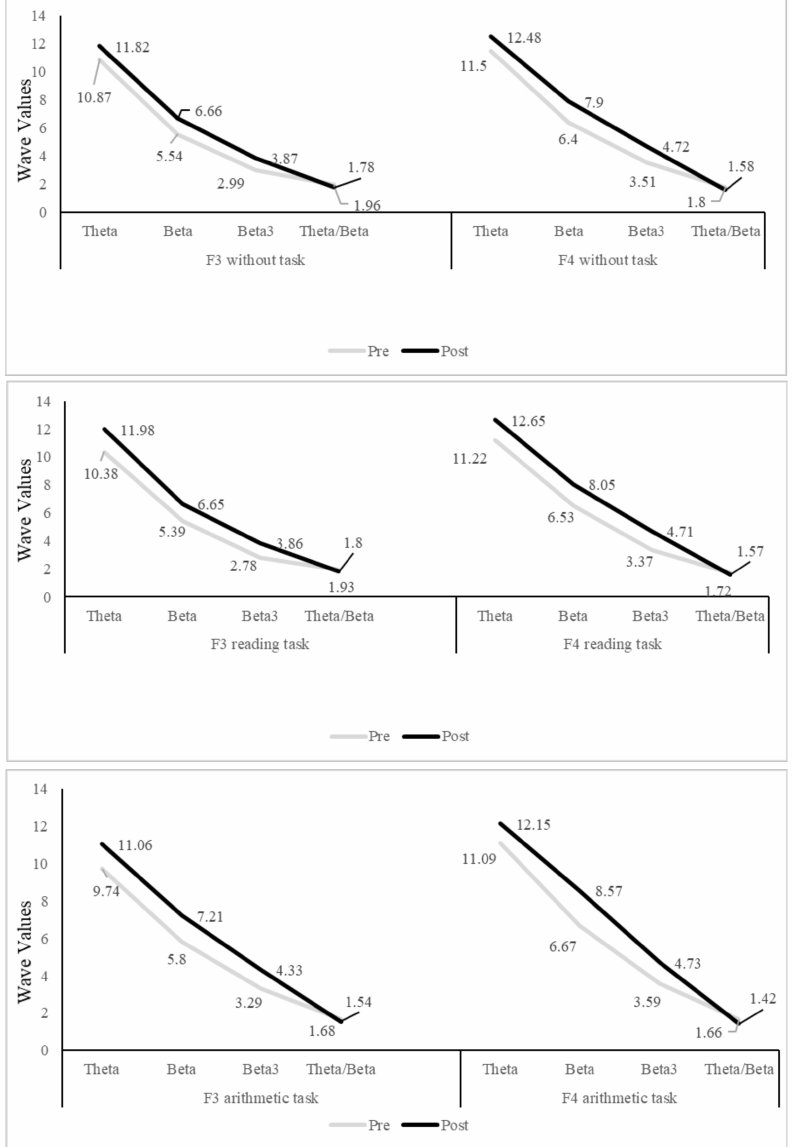
Figure 3. Pre- and post-treatment evolution in F3 and F4 areas with and without